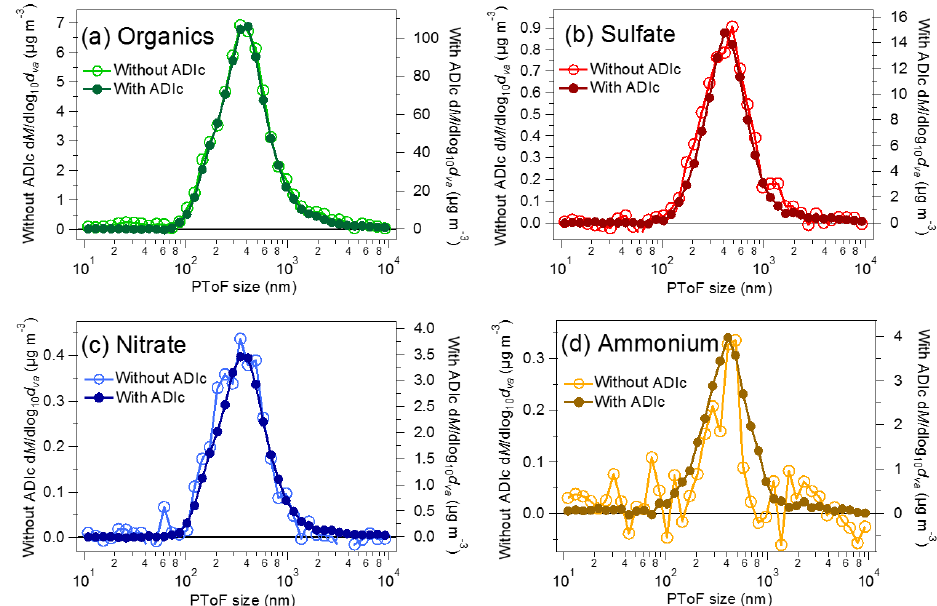
Figure 5. Mass size distributions measured without (left axis) and with (right axis) the ADIc for organics (a) , sulfate (b) , nitrate (c) and ammonium (d) in UMR mode at SMEAR III. Sampling time for each size distribution was 70min with the ADIc and 70min without the ADIc. The theoretical concentration factor was 21.3.